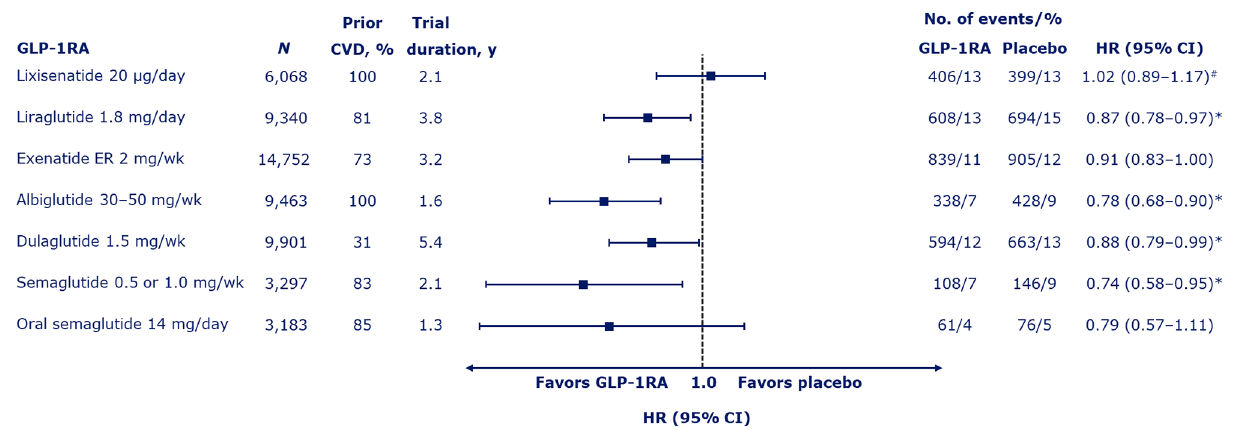
FIGURE 2 | Risk of major adverse cardiovascular events (death from cardiovascular causes, nonfatal myocardial infarction, or nonfatal stroke) with GLP-1RAs (4 – 10). Median duration of the trials shown. # Also includes hospitalization for unstable angina. *Denotes signi fi cant difference (p < 0.05) vs. placebo. CI, con fi dence interval; CVD, cardiovascular disease; ER, extended release; GLP-1RA, glucagon-like peptide-1 receptor agonist; HR, hazard ratio; wk, week; y,